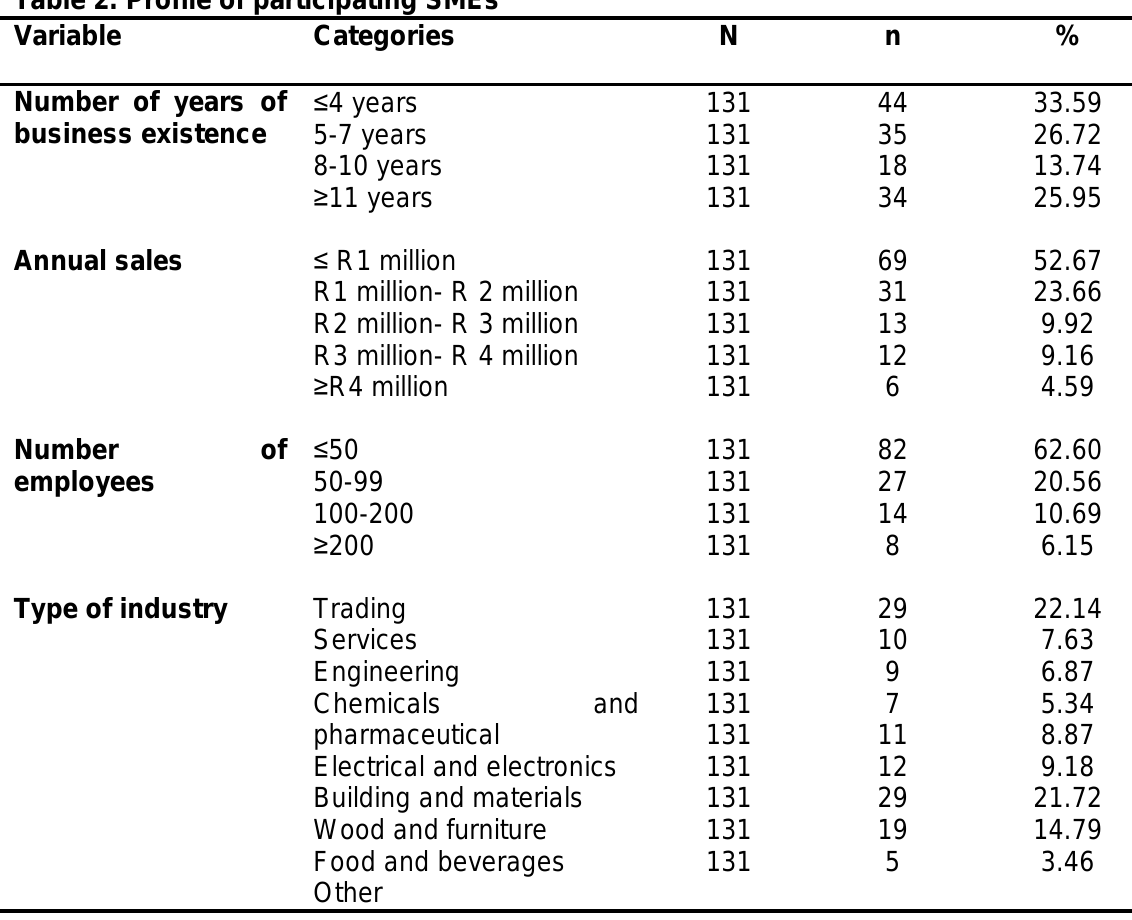
Table 2: Profile of participating SMEs